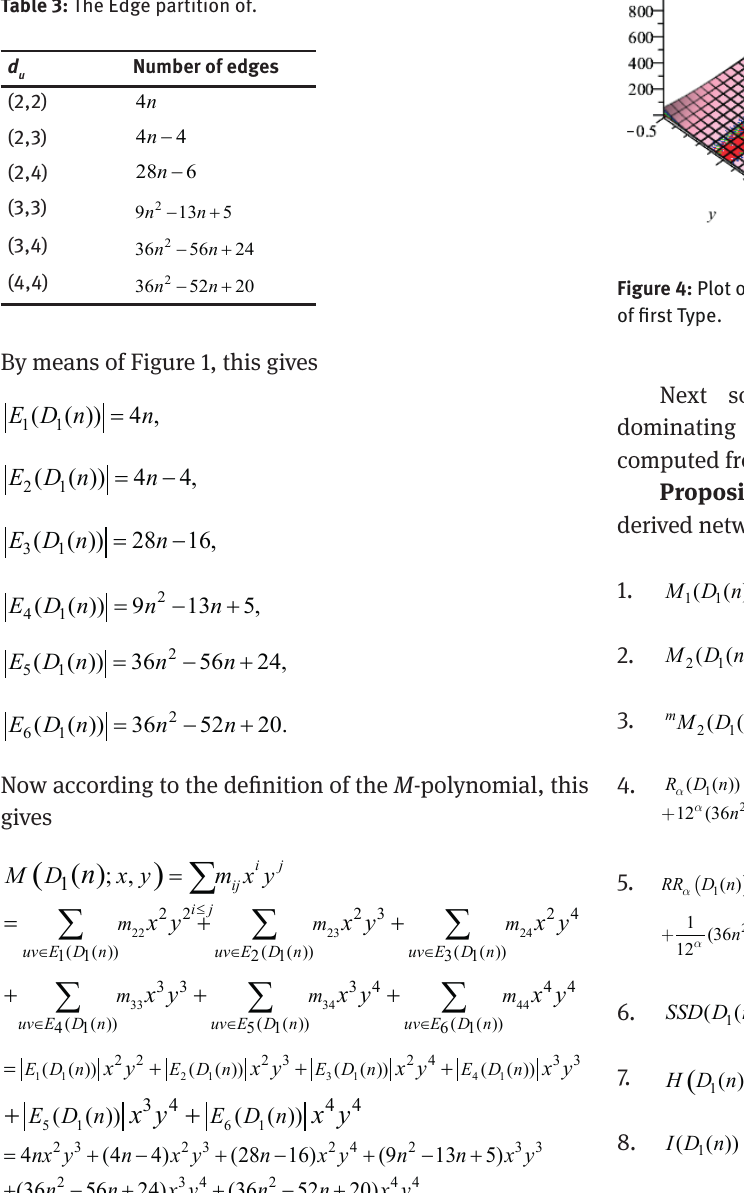
Table 3: The Edge partition of.